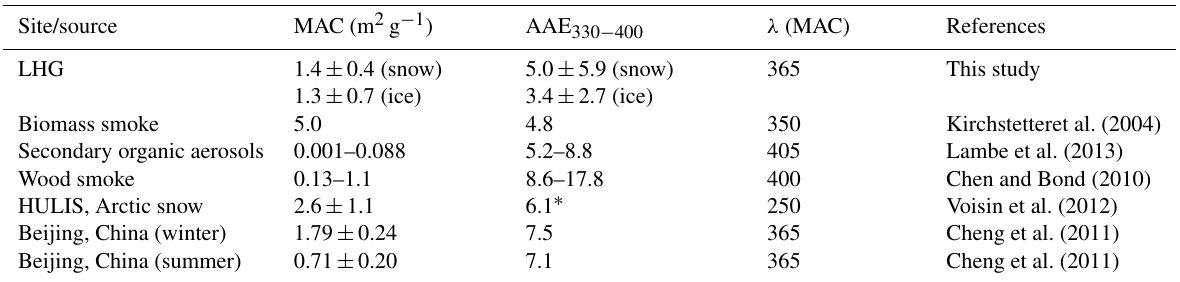
Table 3. Mass absorption cross section (MAC) and absorption Ångström exponent (AAE 330 − 400 ) of ice and snow from LHG and aerosols from other regions.